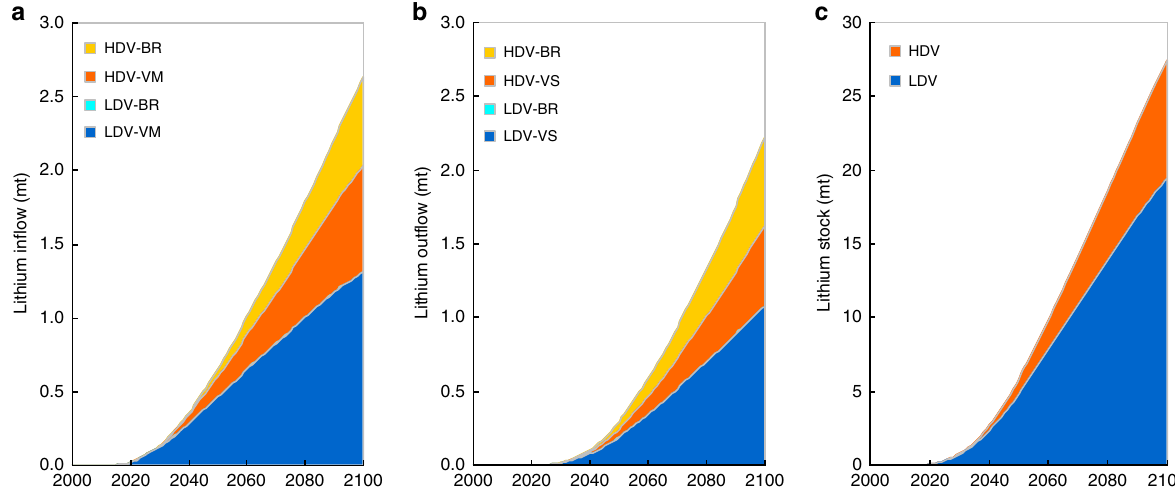
Fig. 1 Annual lithium in fl ow to, out fl ow from and stock in global vehicle fl eet. The sub fi gures show the annual lithium in fl ow ( a ), out fl ow ( b ), and stock ( c ). The results are based on scenario D2. VM: Vehicle Manufacturing; VS: Vehicle Scrappage; BR: Battery Replacement. Source data are provided as a Source Data fi